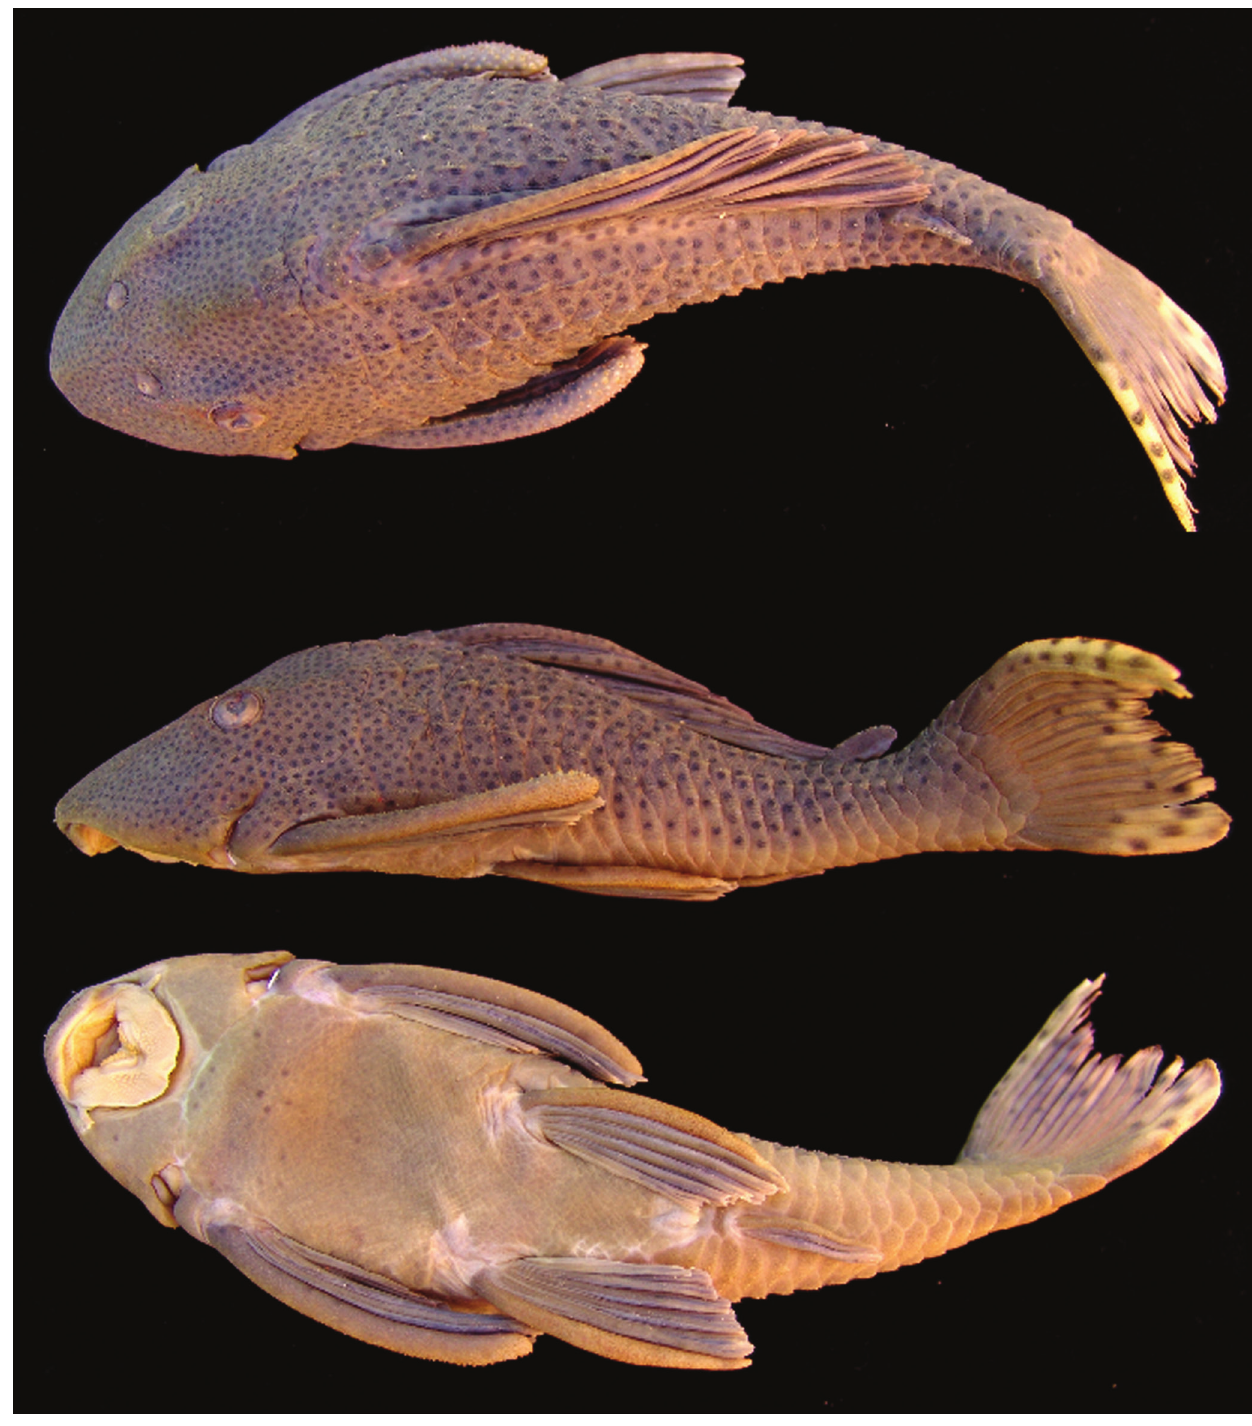
Fig. 1. Hypostomus dardanelos , INPA 37342, 172.2 mm SL, holotype, Brazil, Mato Grosso State, rio Praia Grande, tributary to rio Aripuanã, rio Madeira basin. Picture horizontally